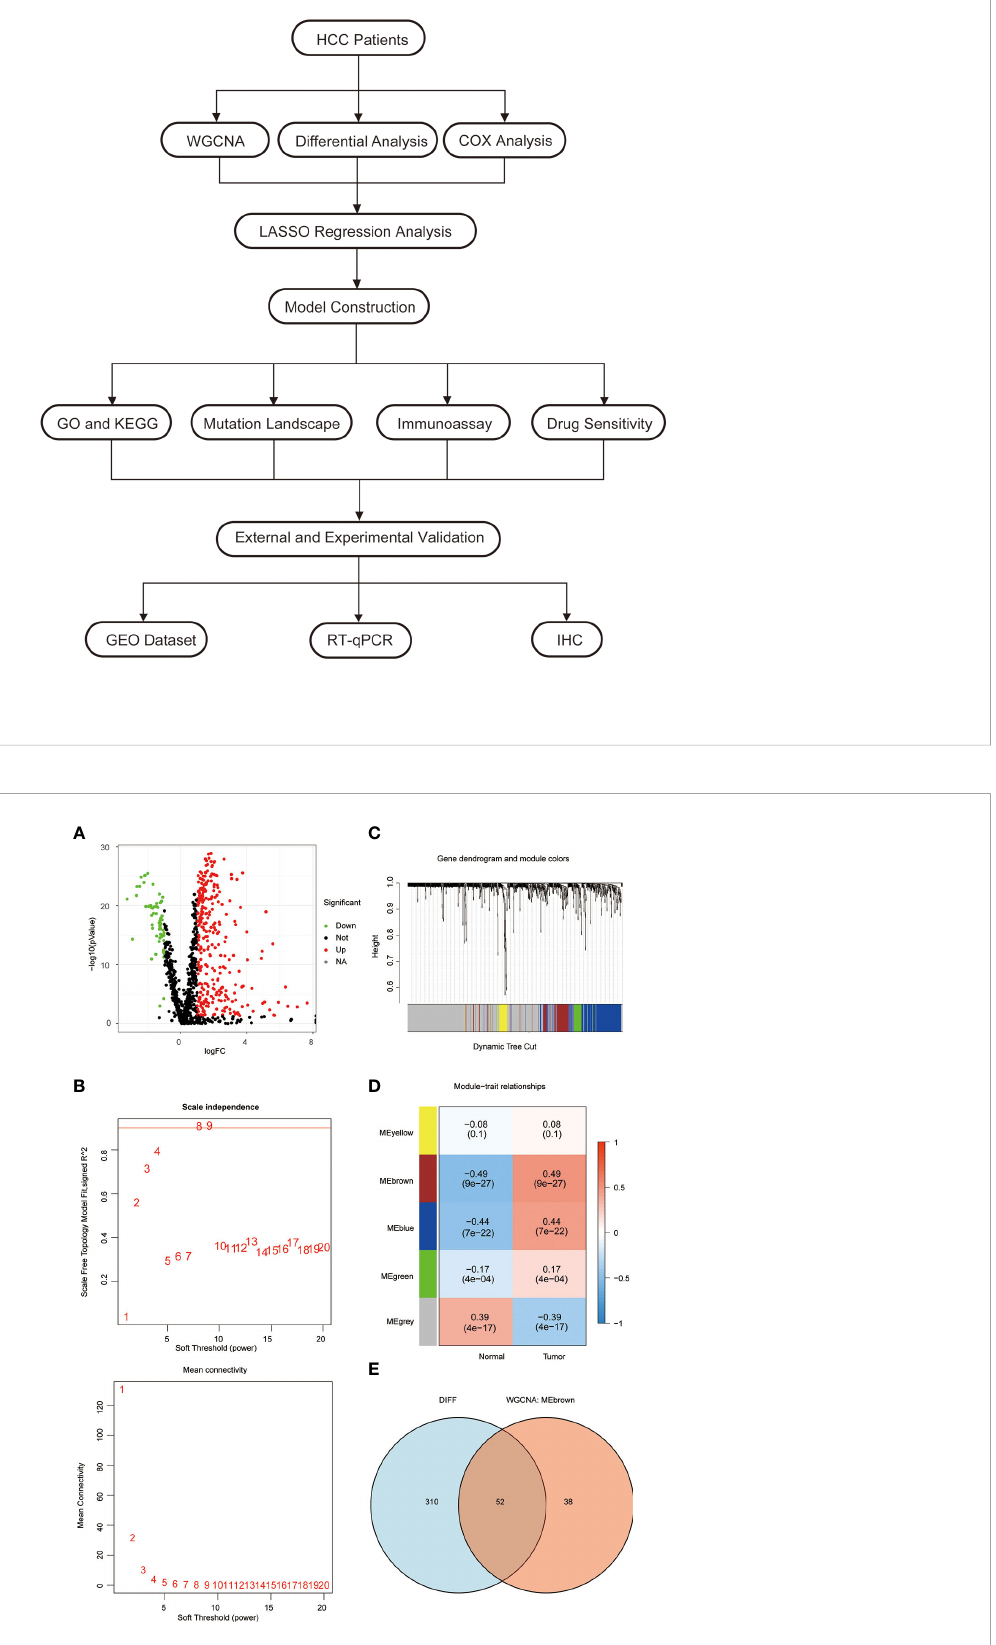
FIGURE 2 WGCNA screening for key genes. (A) The volcano plot clearly shows the differential genes, with a total of 362 differential genes. (B) the optimal soft threshold 8 is used to construct the co-expression network. (C, D) The genes were divided into 5 modules by co-expression network, and the P-value and correlation coef fi cient of each module were clearly marked. (E) VENN plot showing the intersection of differential genes and the MEbrown module of WGCNA with 52